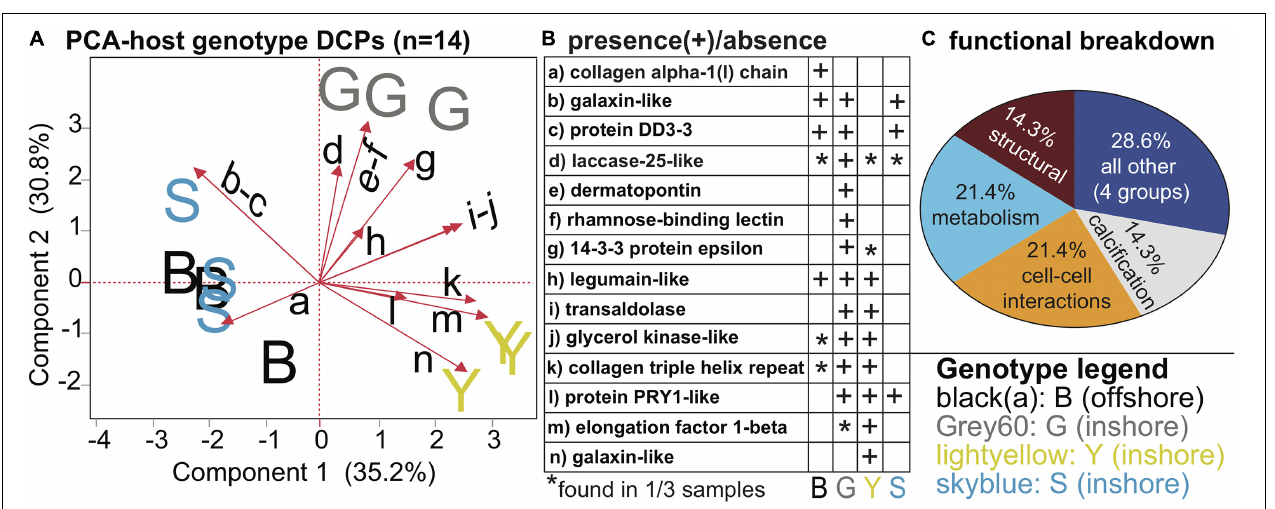
FIGURE 4 | Genotypic differences in Orbicella faveolata proteins. A PCA with the 14 proteins whose concentrations differed significantly across host genotypes (A) . Please note that the black, small-font, lower-case letters adjacent to the biplot rays correspond to the row where the respective data for each protein have been displayed in (B) , and the legend for the sample icons can be found in the bottom right corner. A functional breakdown of these proteins is depicted in (C) . For further details, please see Table 3 and Supplementary Tables 3,